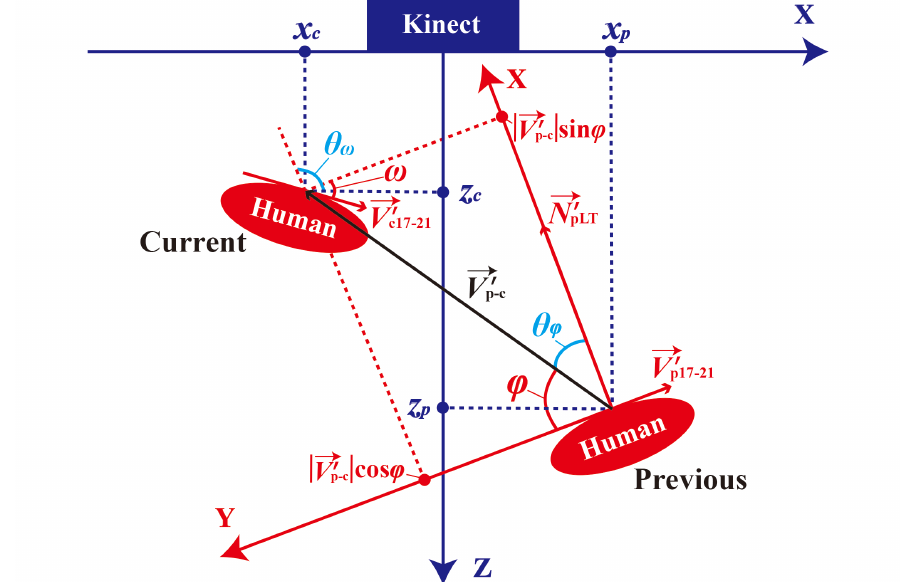
Figure 9. The calculation of the displacement and rotation angle between two adjacent locomotion loops. The blue coordinate axes correspond to the Kinect frame, and the red coordinate axes correspond to the human base